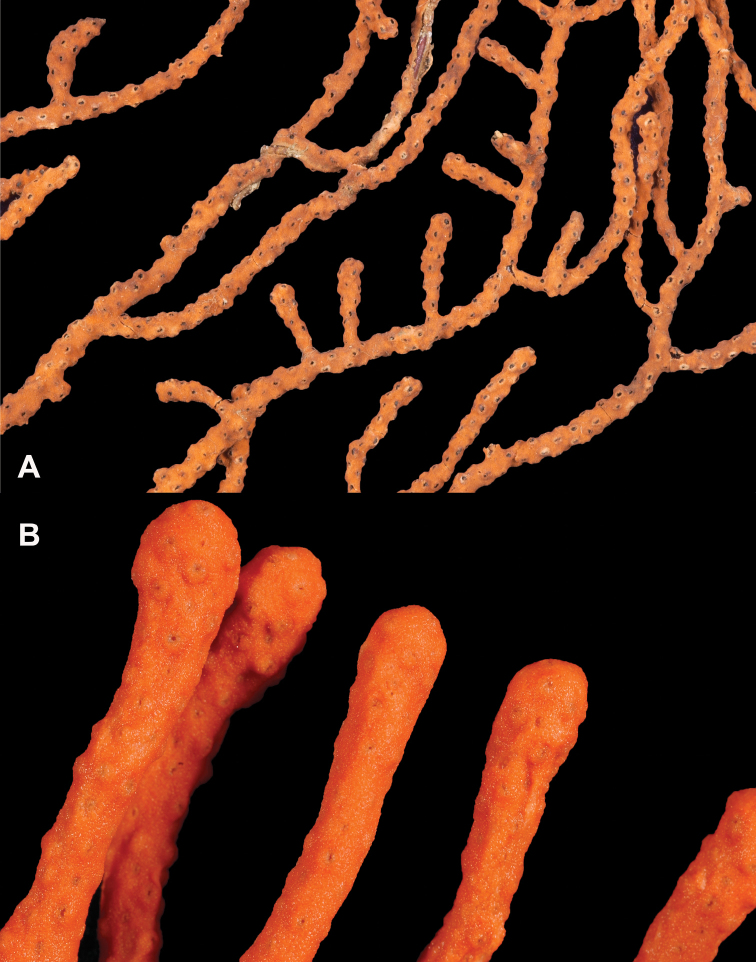
Adelogorgiaphyllosclera. ASBMNH 422403 [dry], slightly magnified image of branches BSBMNH 51252 [wet], rounded, slightly club-shaped branch tips.